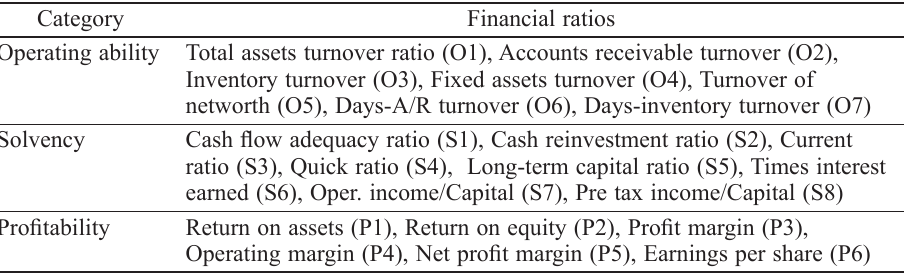
Table 1. The financial indicators on three